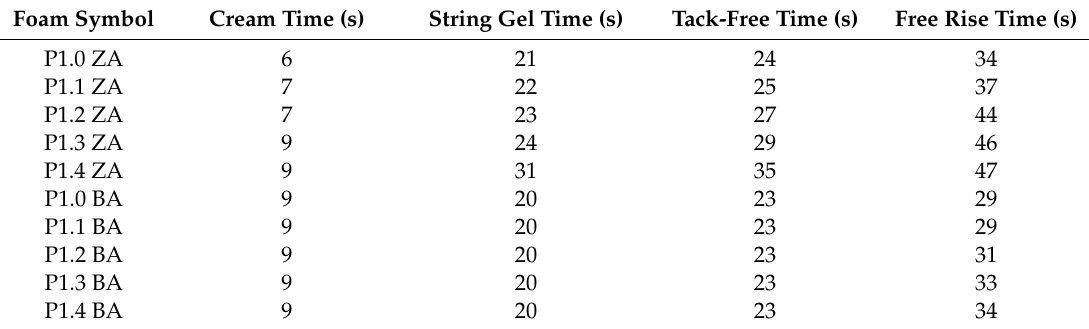
Table 2. Processing times of RPU / PIR foams based on